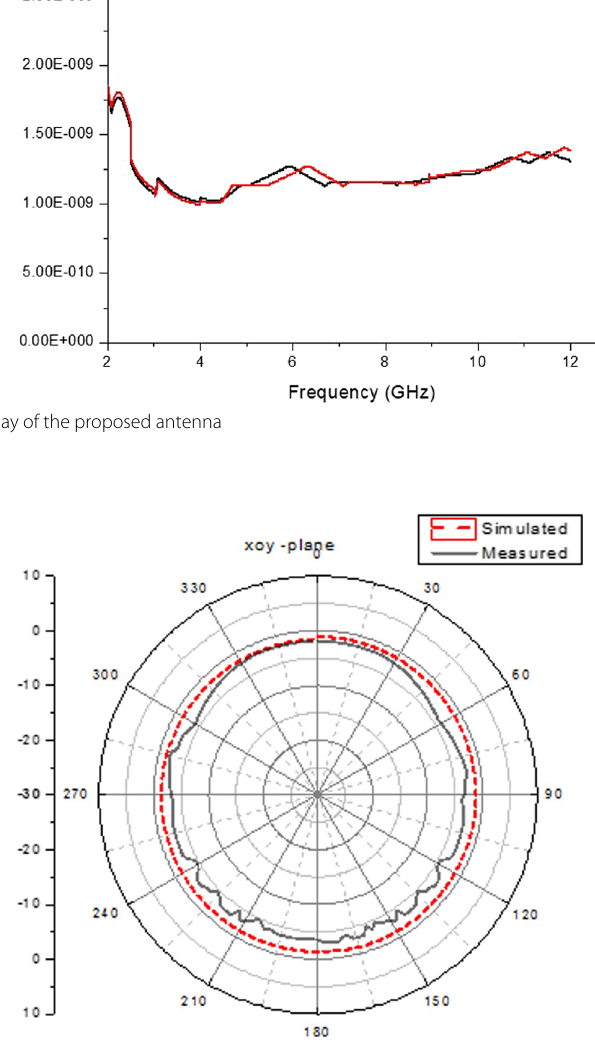
Fig. 9 Simulated MRG and measured MRG in xoy